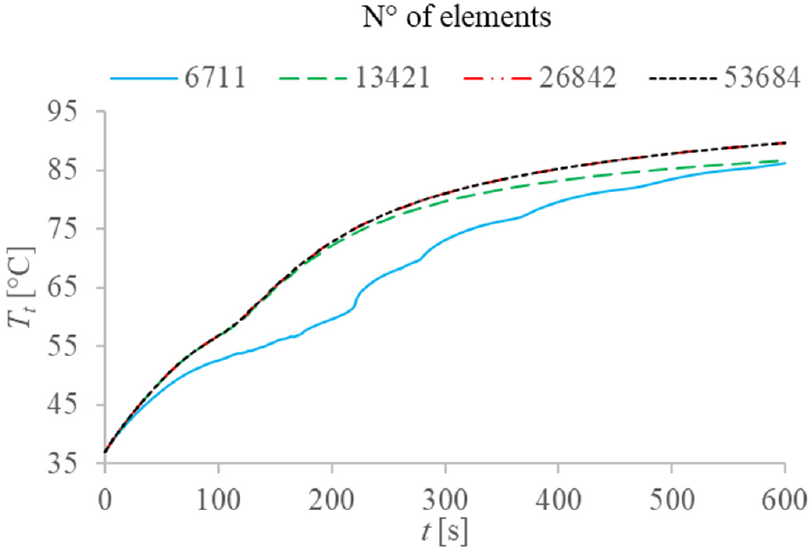
Figure 3. Evaluation of different grids on temperature profile at tumor rim ( r = 1.2 cm; z = 0.0 cm).